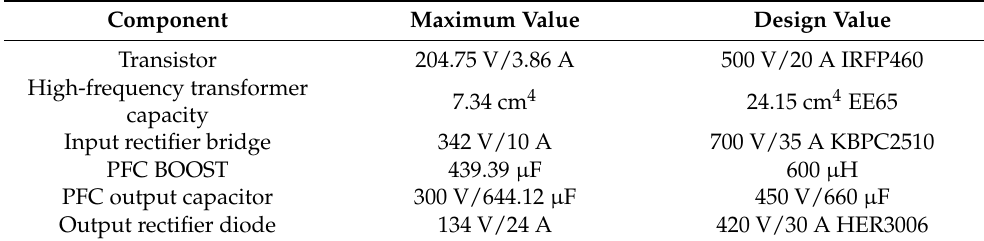
Table 3 lists key component derating design parameters. Table 3. Derating design parameters of key